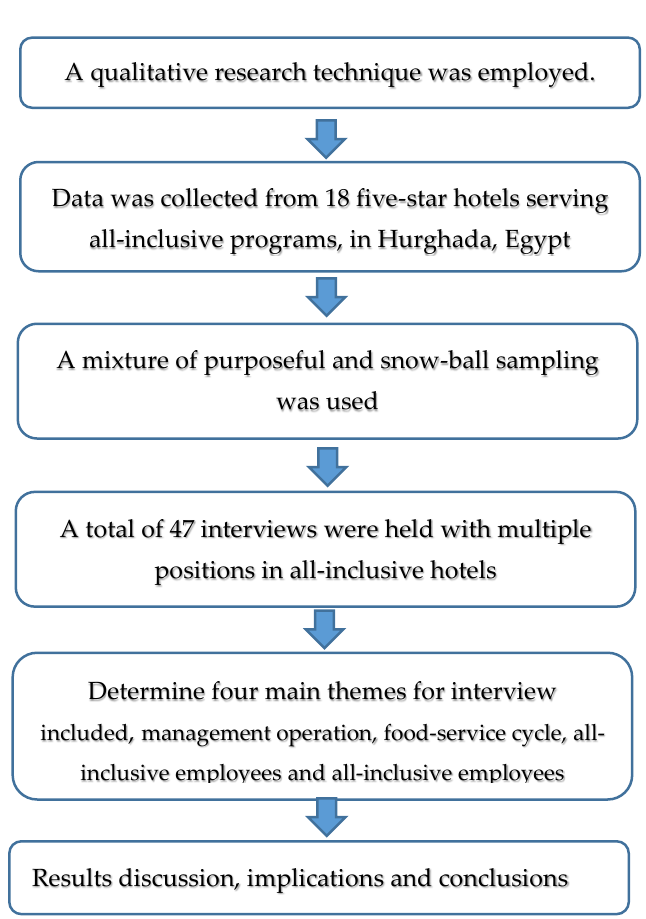
Figure 3. The framework of research